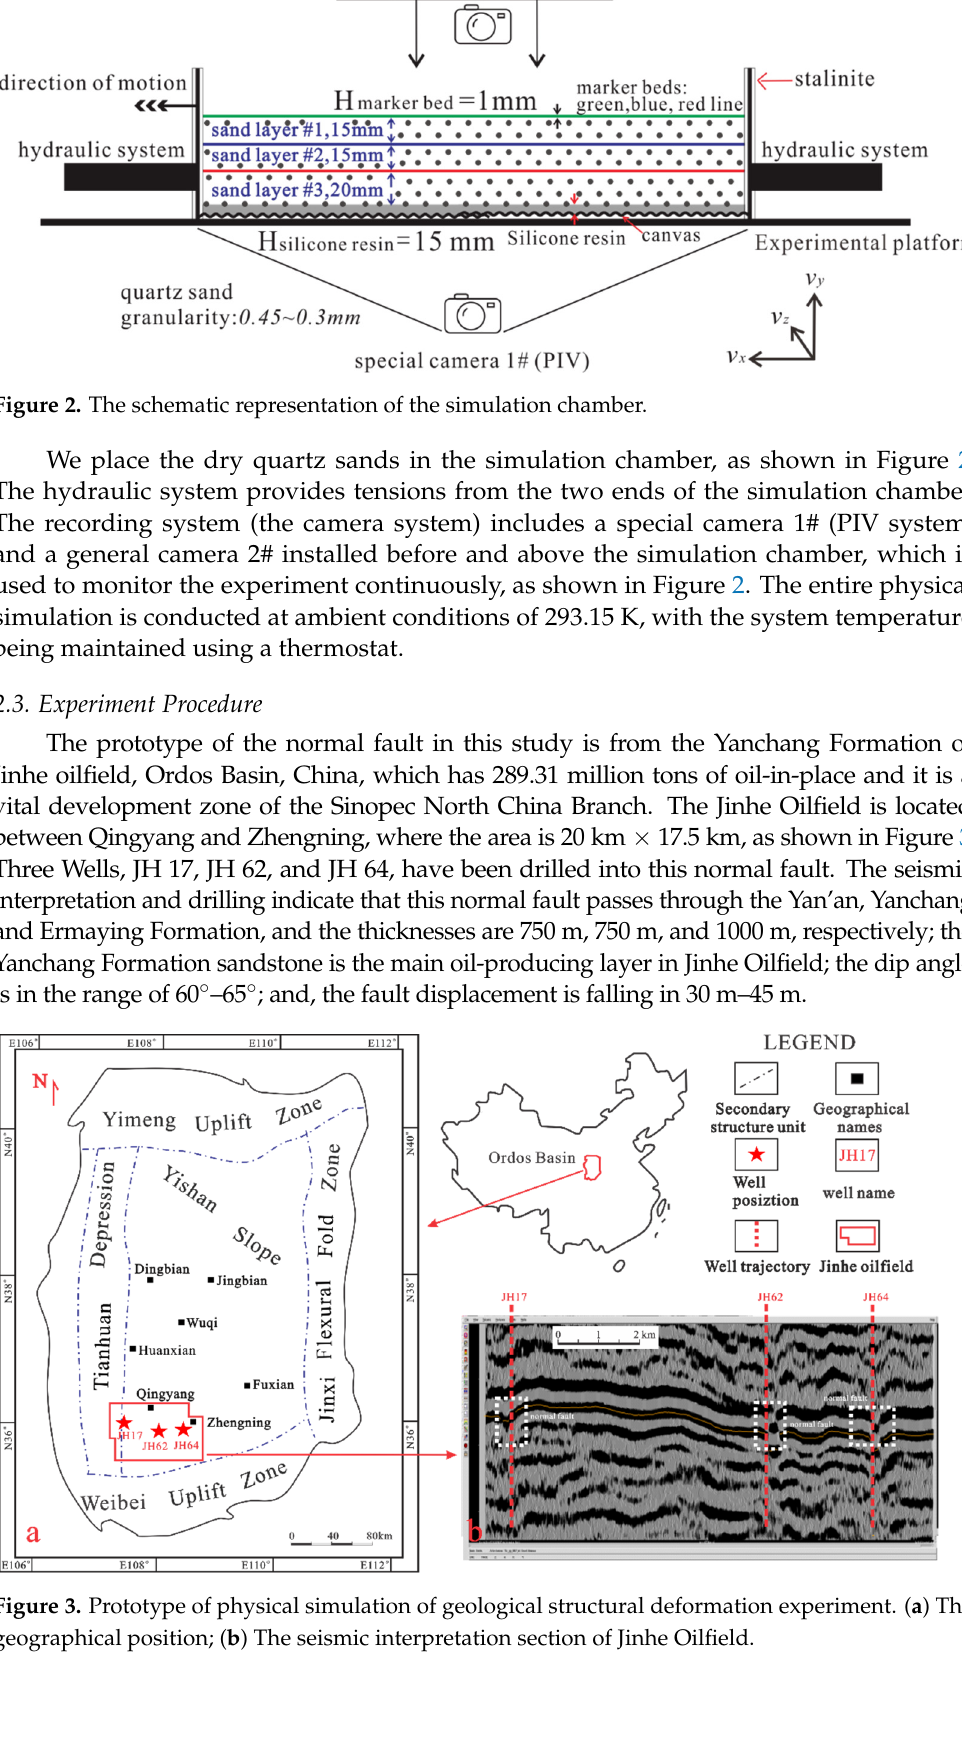
Figure 3. Prototype of physical simulation of geological structural deformation experiment. ( a ) The geographical position; ( b ) The seismic interpretation section of Jinhe Oilfield.